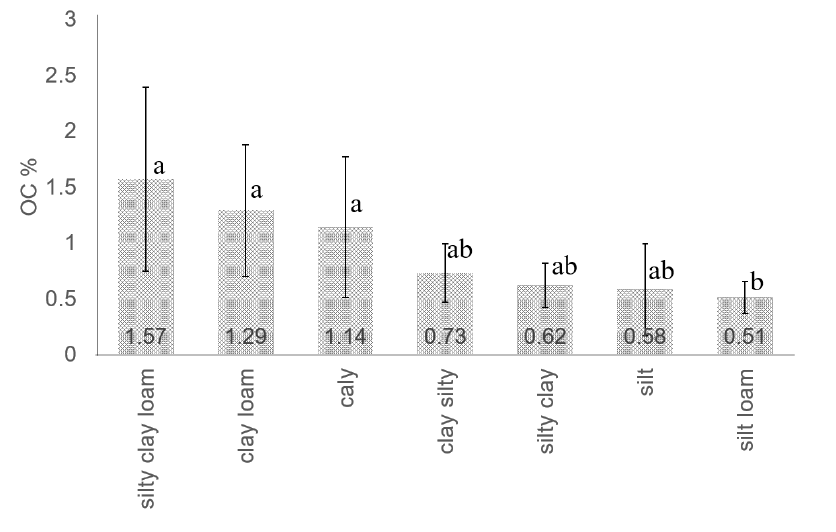
Figure 4. SOC concentration (%) for the surface horizon (Hz1). Different letters indicate significant differences based on soil texture according to the Kruskal–Wallis test, ( p <